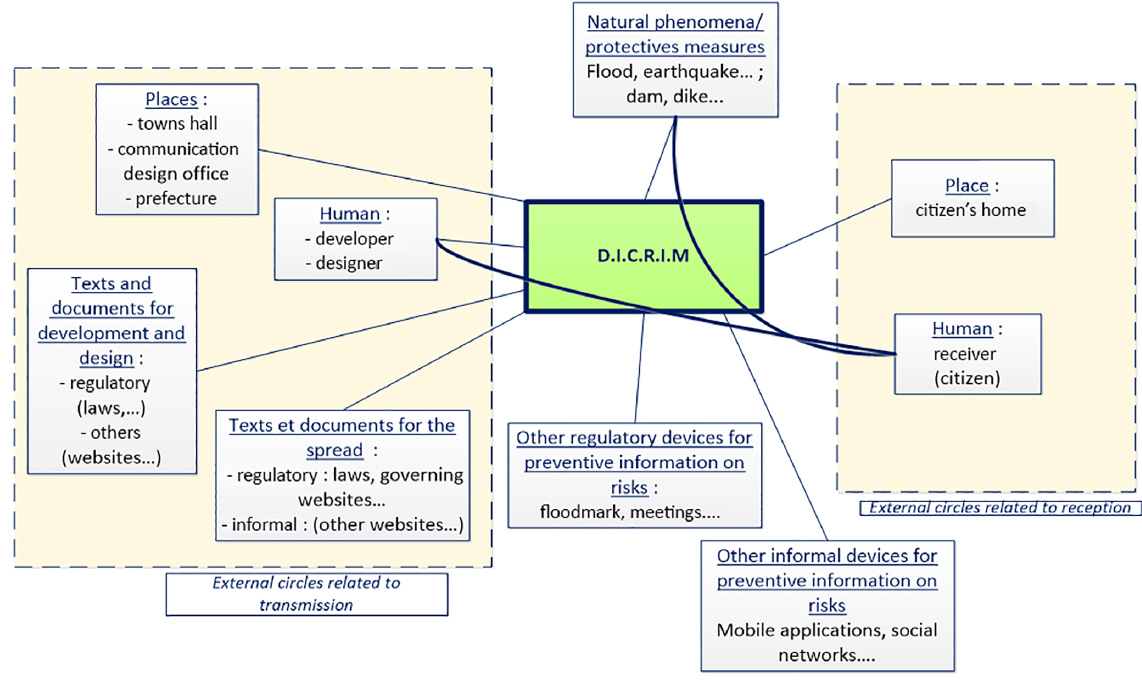
Figure 3. Functional block diagram for